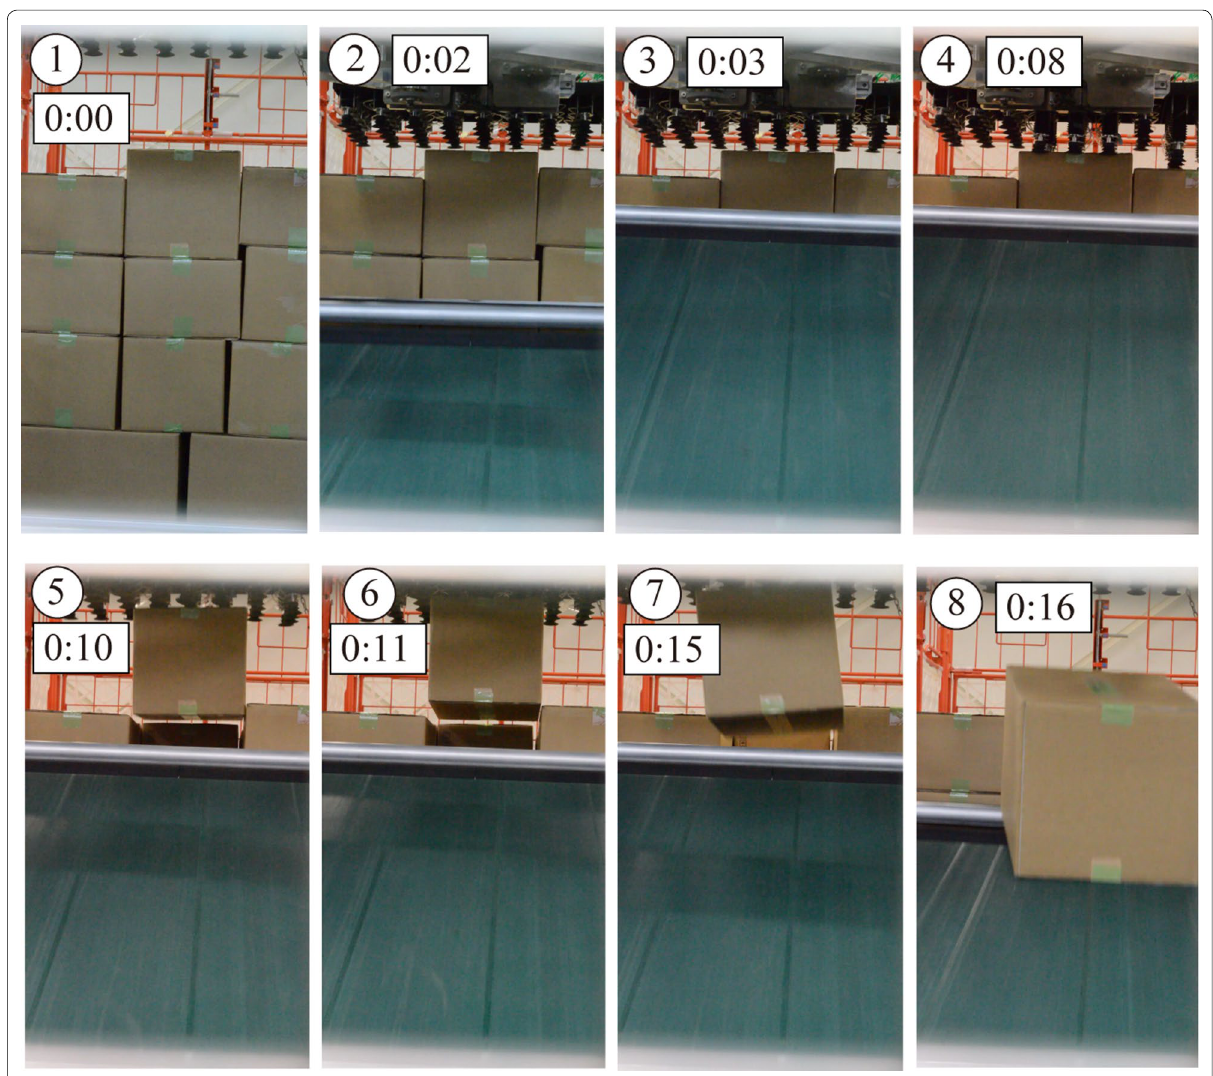
Fig. 34 Part of the verification operation (extracting one cardboard